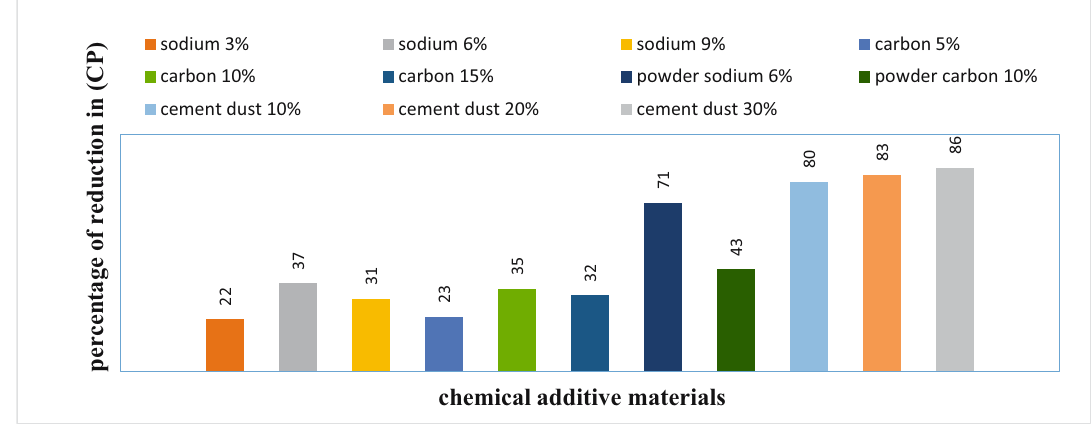
Figure 8: Percentage of improving the CP of treated soil with chemical additive materials.